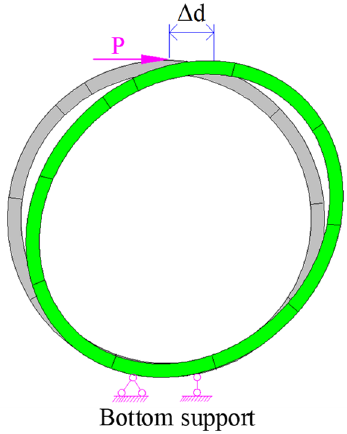
Figure 4. Sketch of the numerical simulation model.